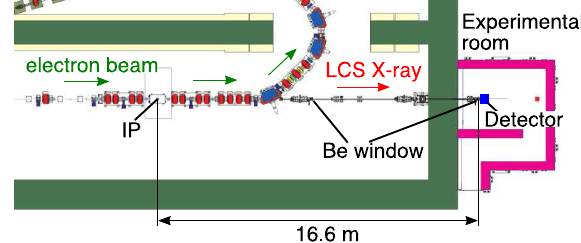
FIG. 6. Schematic drawing of the LCS beam